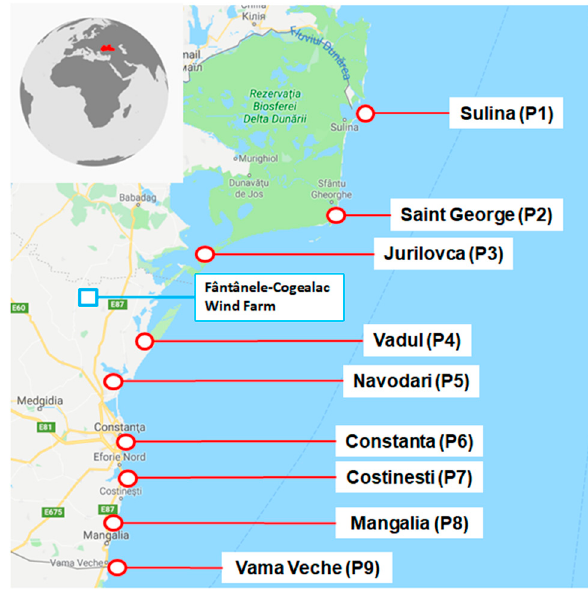
Figure 1. The Romanian coastal area and the onshore reference sites considered for assessment (map from Google Earth, 2019).